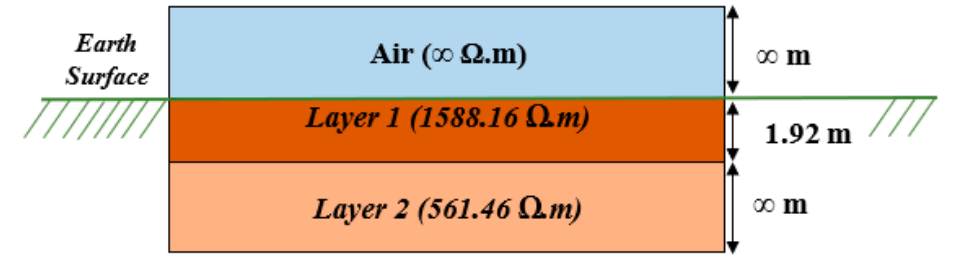
Figure 12. Tower T44 soil profile interpretation.